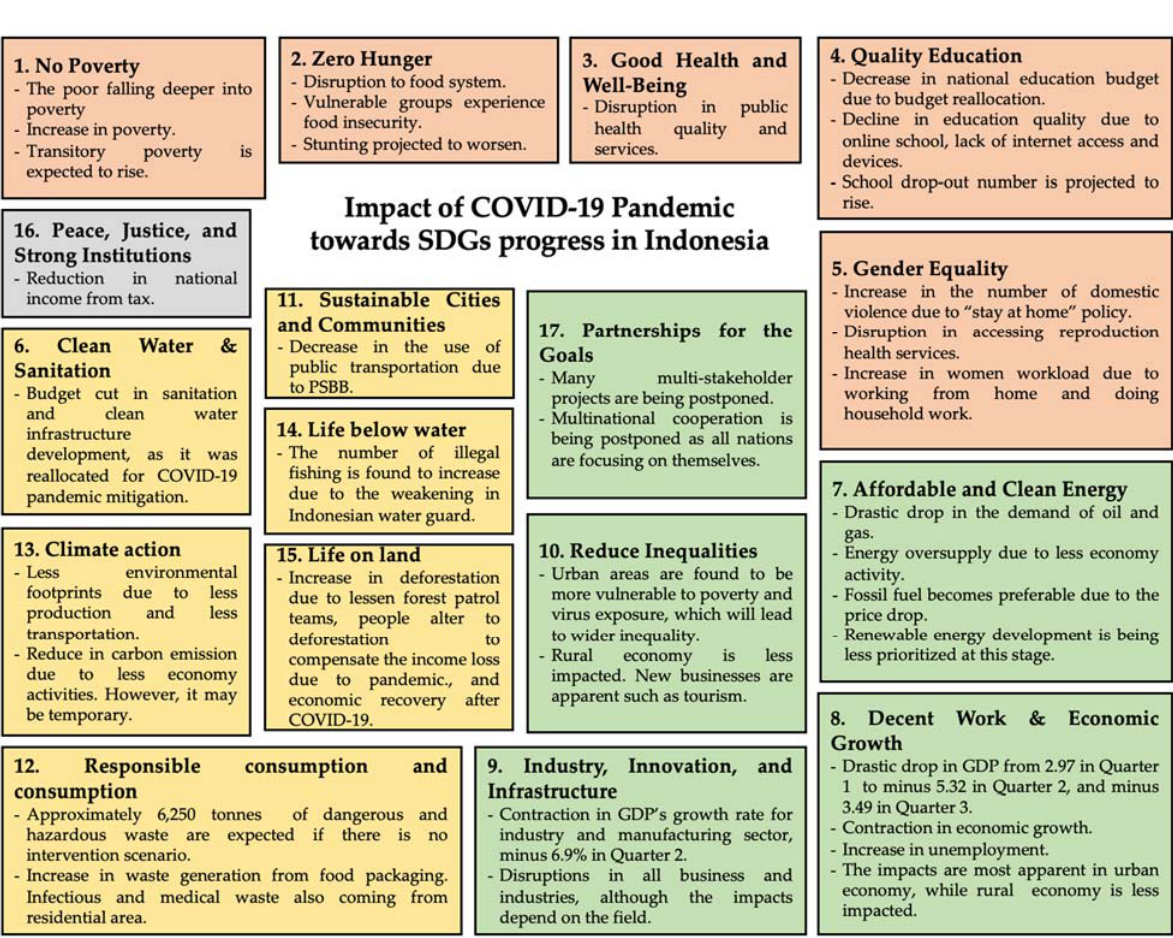
Figure 6. The summary of COVID-19 pandemic towards SDG progress in Indonesia.